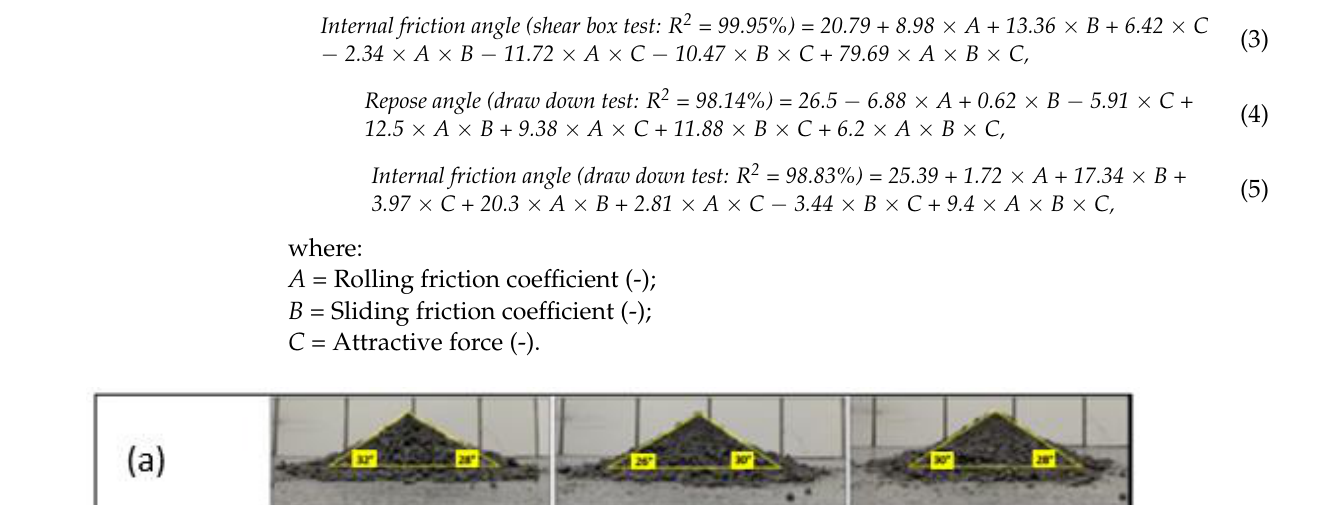
Table 4. Summary of size distribution and gold grade based on particle group. Group